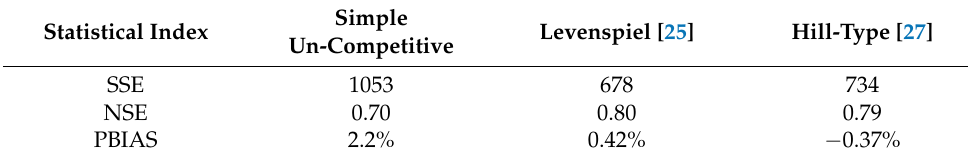
Table 2. The statistic indices for the FA inhibition models examined.